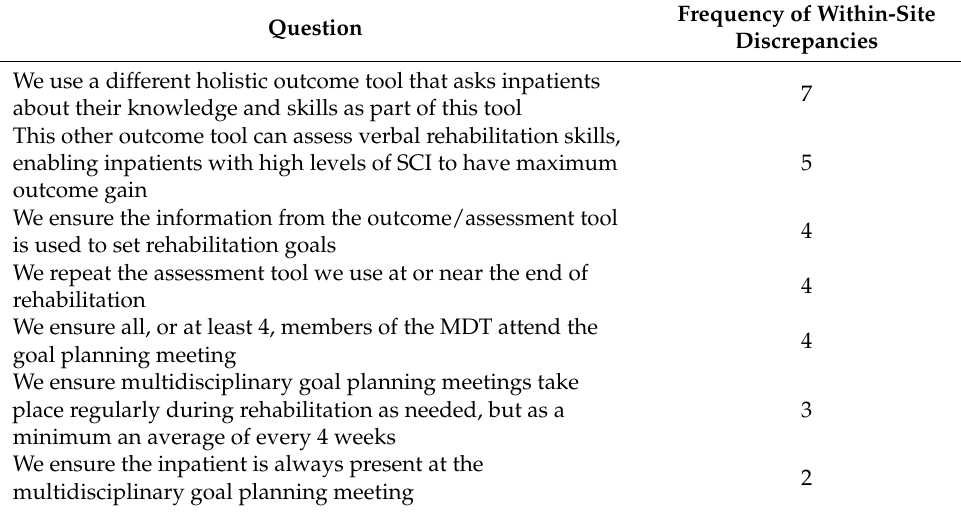
Table 10. Within-site response discrepancies.